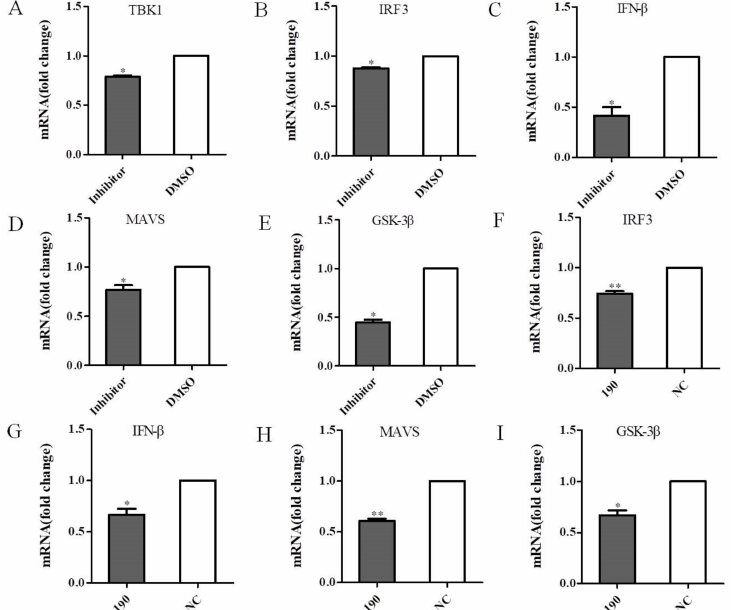
Figure 8. Inhibition of TBK1 decreases the antiviral signaling. ( A – E ) DEF cells were treated with 40 µ M Amlexanox as the experimental group, and DEF cells were treated with DMSO as the carrier control, and then infected with DEV at a MOI of 0.1 prior to qRT-PCR analysis. ( A ) TBK1 mRNA expression levels. ( B ) IRF3 mRNA expression levels. ( C ) IFN- β mRNA expression levels. ( D ) MAVS mRNA expression levels. ( E ) GSK-3 β mRNA expression levels. ( F – H ) DEF cells transfected with siTBK1-190 and infected with DEV at a MOI of 0.1. ( F ) IRF3 mRNA expression levels. ( G ) IFN- β mRNA expression levels. ( H ) MAVS mRNA expression levels. ( I ) GSK-3 β mRNA expression levels. Mean ± SD of three technical replicates are shown. * p < 0.05, ** p < 0.01.